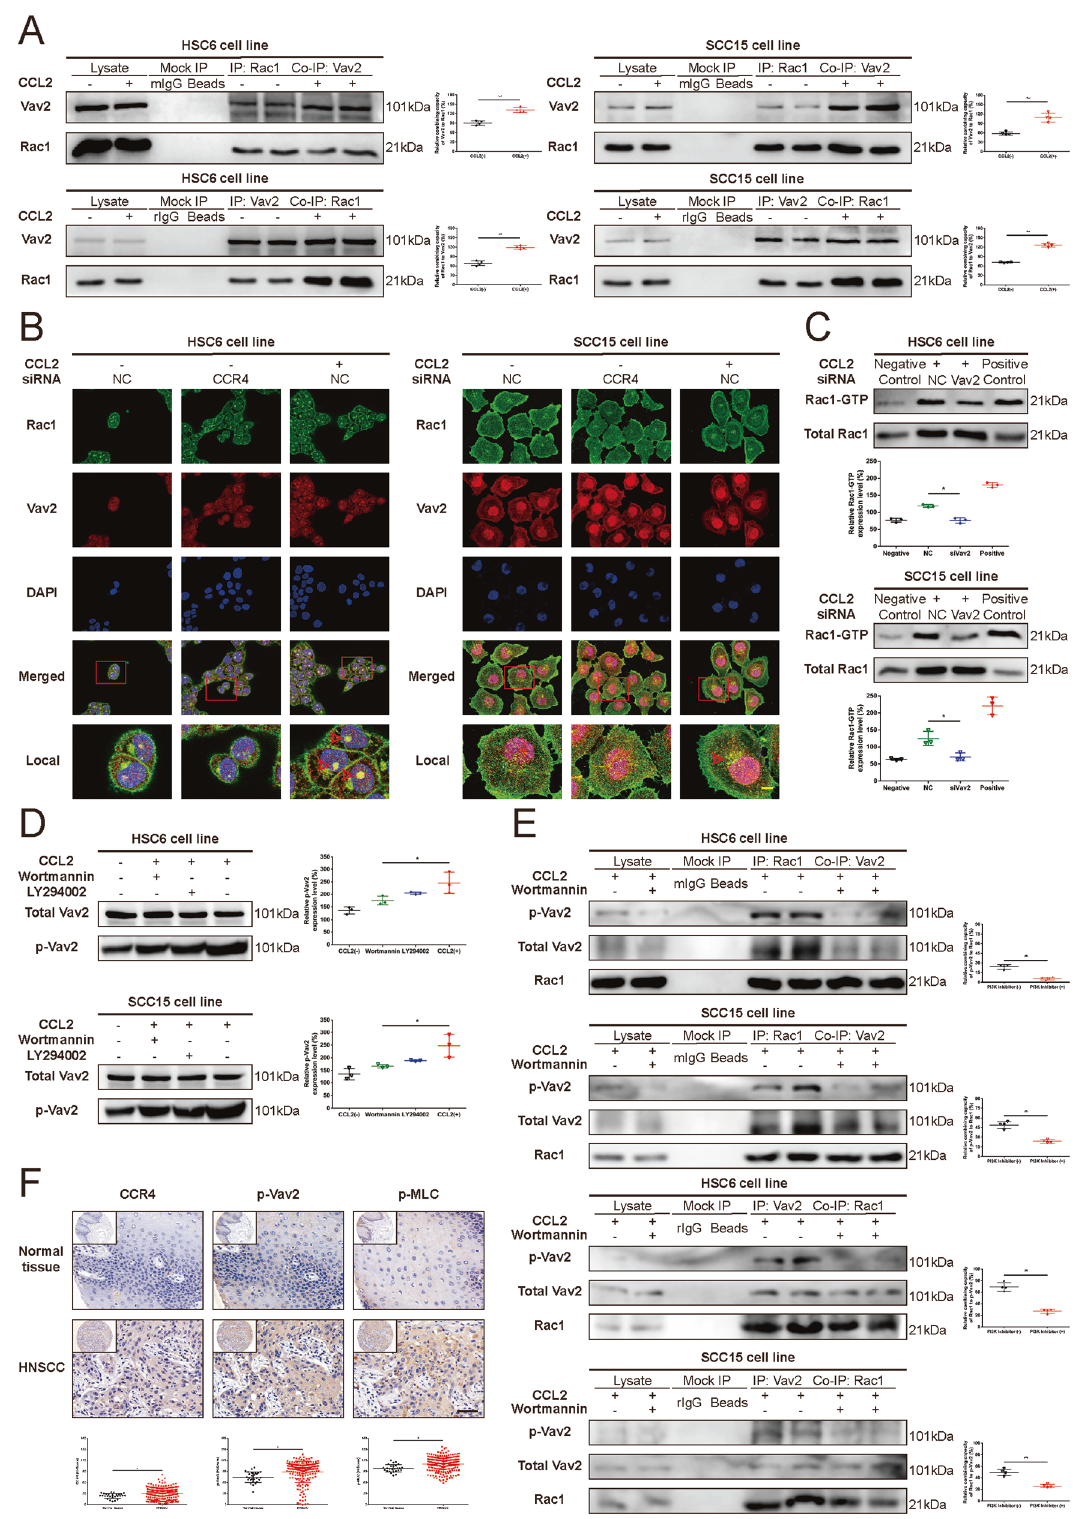
Enzyme-linked immunosorbent assay (ELISA) CCL2 levels were detected in the cell culture supernatant for 48 h in respective conditions and quanti fi ed using Human CCL2 ELISA Kit (Telenbiotech, Guangzhou, GD, CN) according to the manufacturer ’ s instructions. CCL17 and CCL22 levels were detected in the cell culture supernatant collected from HSC6 and SCC15 cells cultured with or without